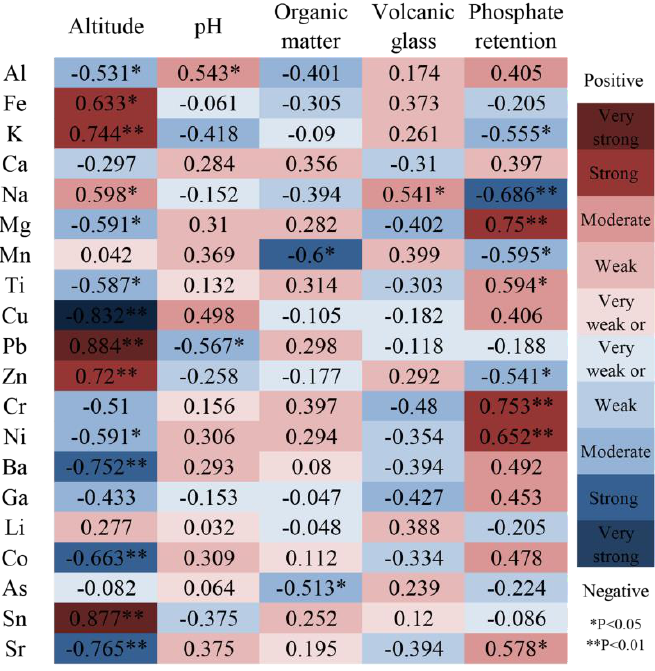
Figure 3. Pearson’s correlation coe ffi cient between metal concentration and altitude, pH, organic Figure 3. Pearson ’ s correlation coefficient between metal concentration and altitude, pH, organic matter, volcanic glass and phosphate matter, volcanic glass and phosphate retention.